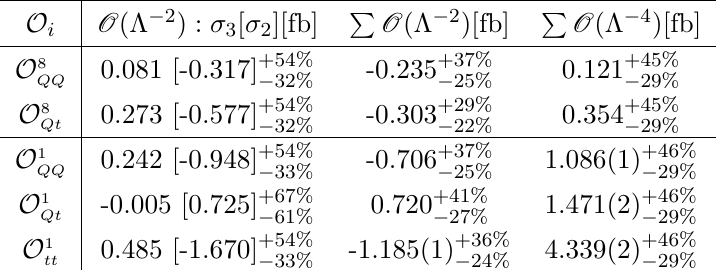
Table 7 . Bounds on the contributing two-fermion and purely-bosonic WCs from the global analysis of ref. [29], except for the O operator. G